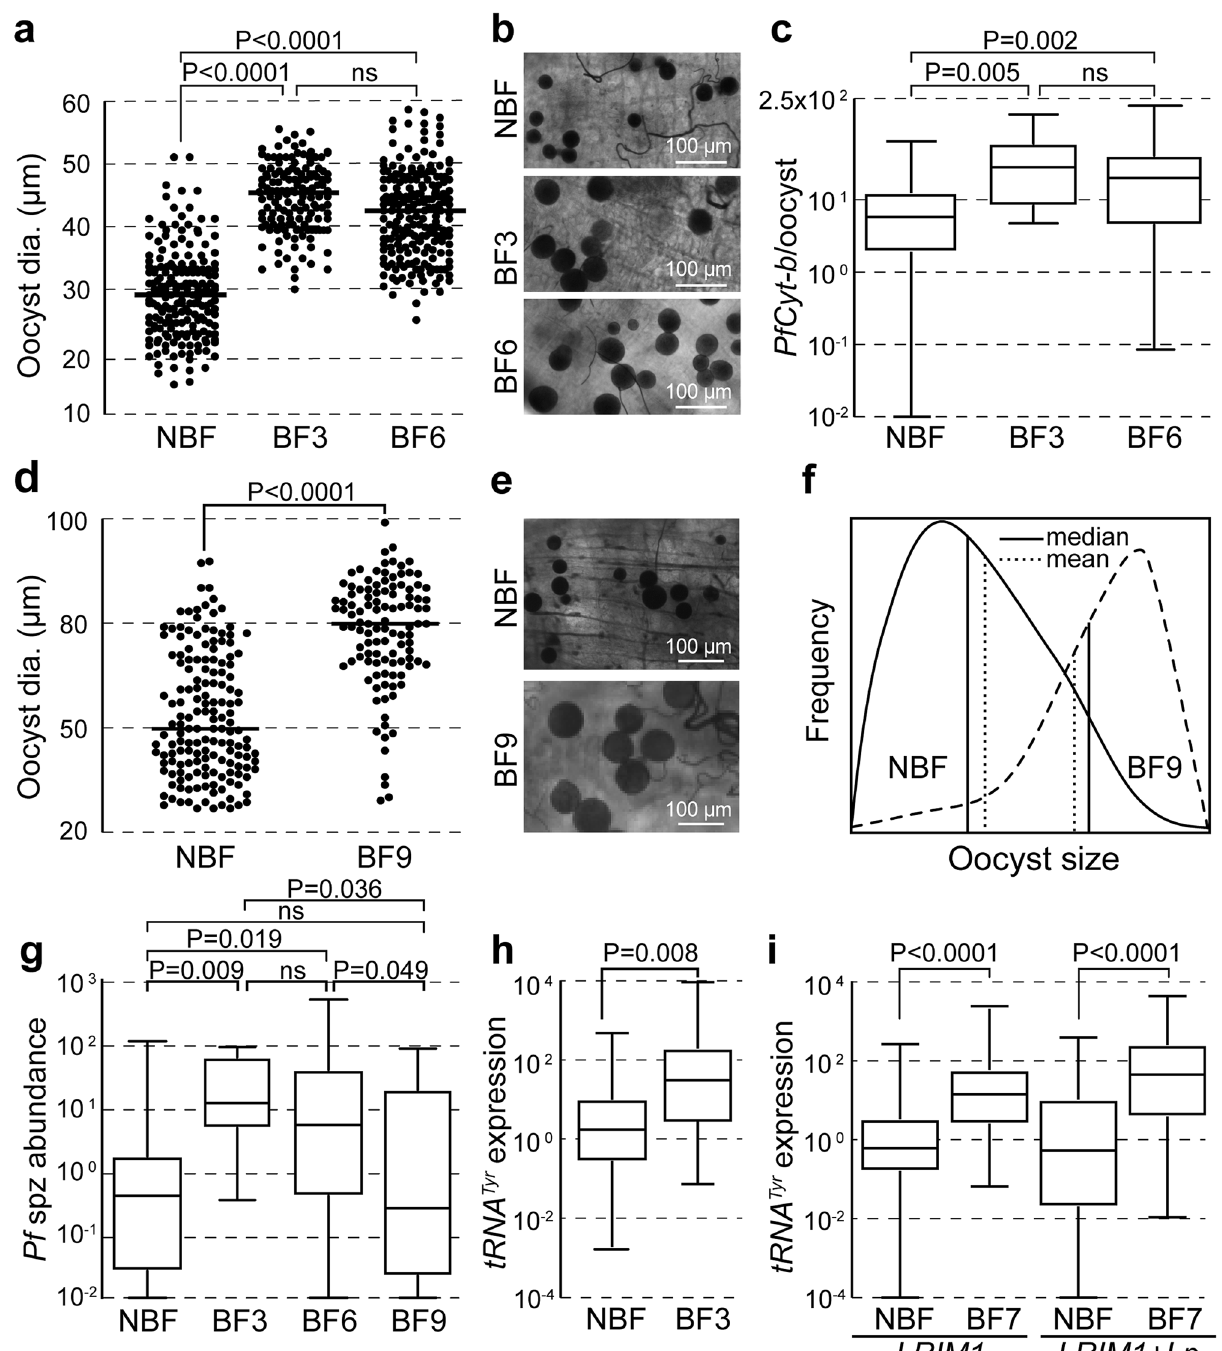
Figure 4. Effect of supplemental bloodmeal deprivation on oocyst development. ( a ) P. falciparum oocyst diameter (dia.) in mosquitoes provided no supplemental bloodmeal after the time of infection (non-blood- fed; NBF) or additional supplemental bloodmeals at 3 (BF3) or 6 (BF6) dpi measured 9 dpi. ( b ) Representative microscopic pictures of P. falciparum oocysts in NBF, BF3 and BF6 mosquitoes taken 9 dpi. ( c ) PfCyt-b DNA abundance in NBF, BF3 and BF6 mosquitoes 9 dpi. ( d ) P. falciparum oocyst diameter (dia.) in mosquitoes provided no supplemental bloodmeal after the time of infection (NBF) or additional supplemental bloodmeals 9 dpi (BF9) measured 13 dpi. ( e ) Representative microscopic pictures of oocysts in NBF and BF9 mosquitoes taken 13 dpi. ( f ) Oocyst size distribution fitting the Poisson distribution model in NBF and BF9 mosquitoes 13 dpi. Solid vertical lines show median and dotted vertical lines show mean. ( g ) Sporozoite load in NBF, BF3, BF6 and BF9 mosquitoes at 14 dpi. ( h ) Relative expression levels of P. falciparum pre-tRNA Tyr in NBF and BF3 mosquitoes measured 7 dpi. ( i ) Relative expression levels of P. berghei pre-tRNA Tyr in LRIM1 and LRIM1 + Lp silenced mosquitoes in NBF and BF7 mosquitoes at 14 dpi. Horizontal lines in dot plots and boxplots indicate median. Data were generated from at least two independent biological